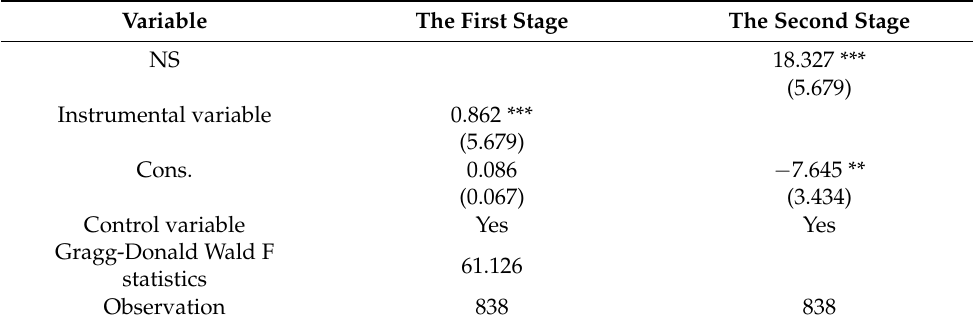
Table 6. 2SLS regression results of non-cognitive